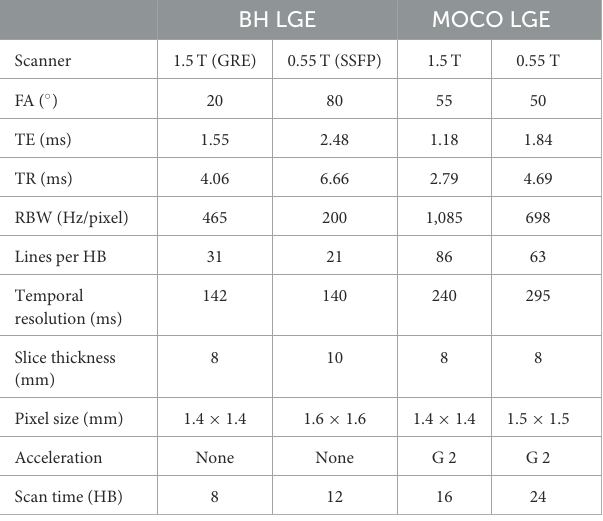
TABLE 5 Acquisition parameters for late gadolinium enhancement (LGE) images at 0.55T in comparison to 1.5T. BH LGE MOCO LGE